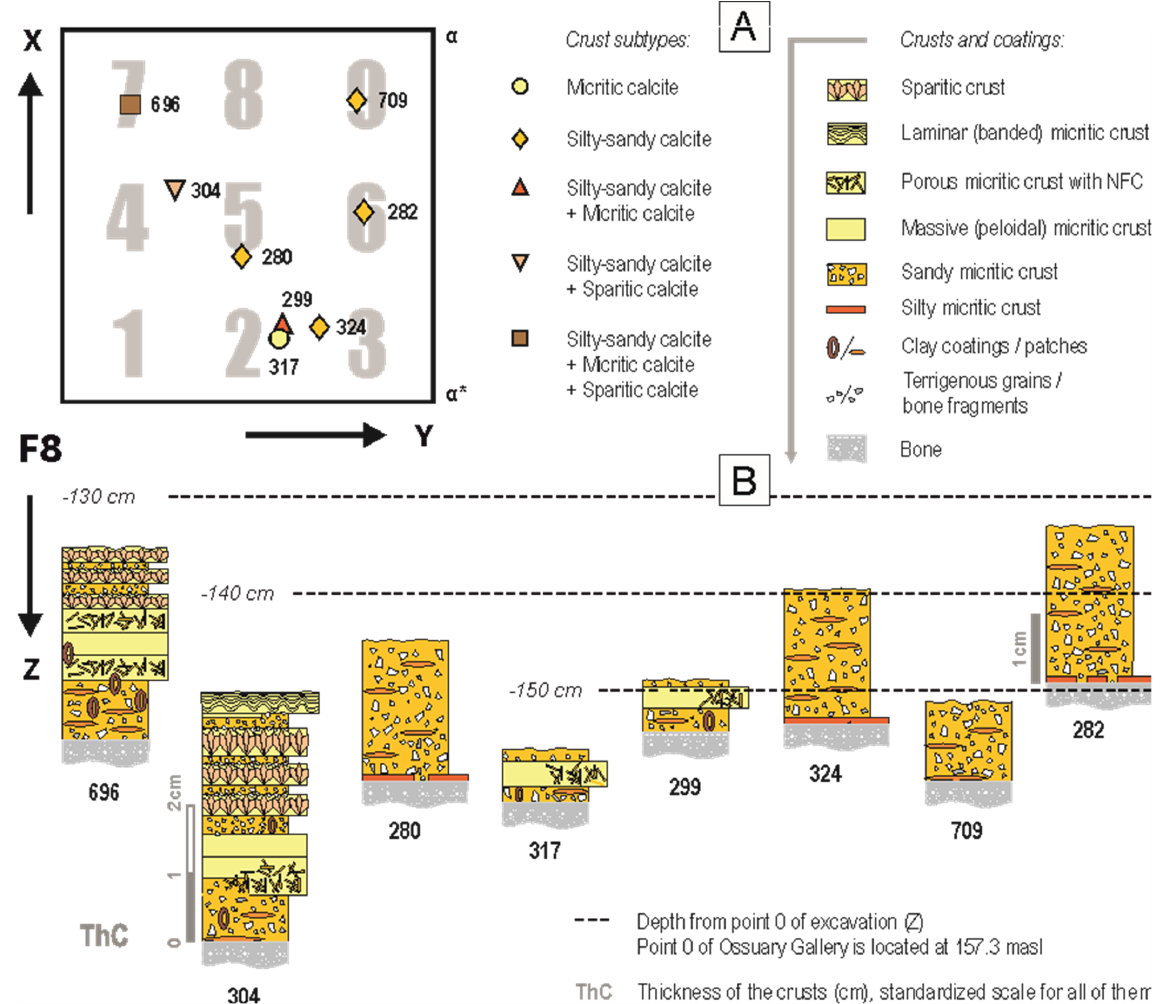
Figure 6. Distribution of the different types of carbonate crusts (hard coatings) recognized over the Neanderthal bones (square F8): ( a ) horizontal distribution and crust associations; ( b ) vertical distribution and thickness of the crusts. See Figures 1 and 3 for locations in the Ossuary Gallery map.